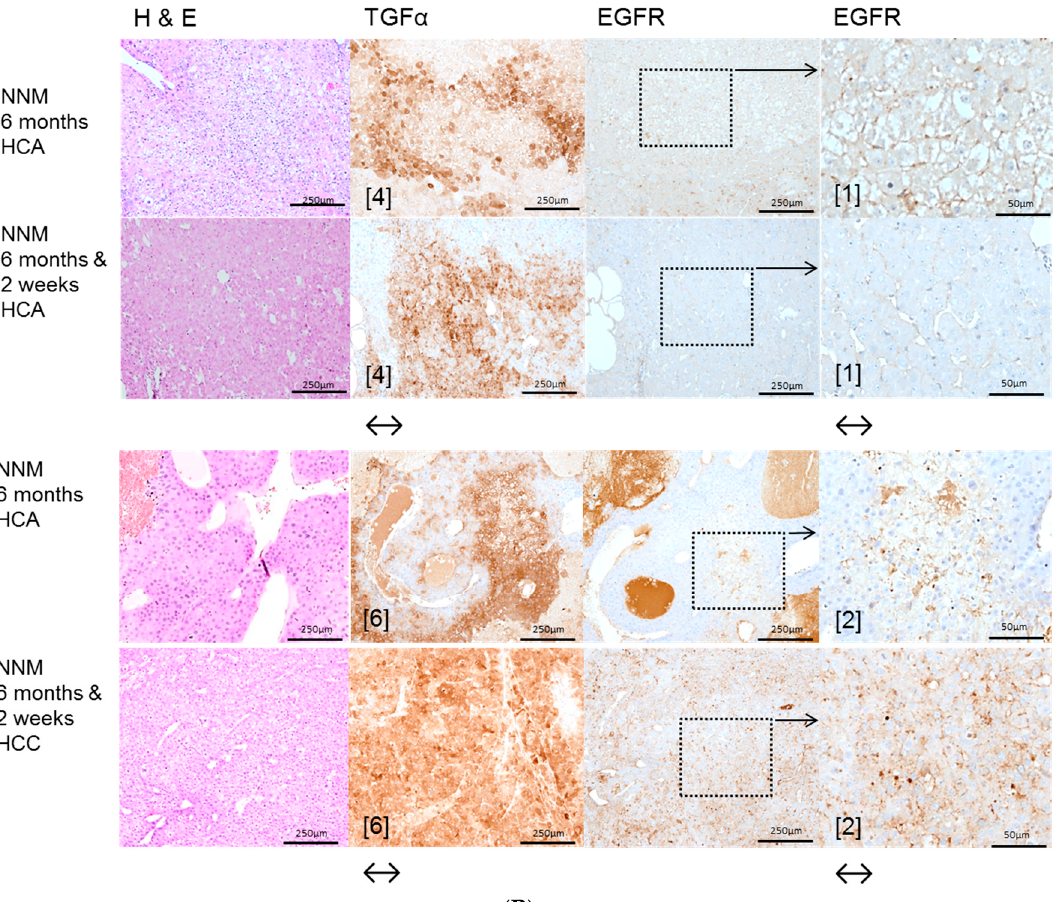
Figure 1. Effects of Gefitinib at six months after administration of N -Nitrosomorpholine (NNM) and expression patterns of epidermal growth factor receptor (EGFR), transforming growth factor α (TGF α ) and downstream signaling in pre-neoplastic foci of altered hepatocytes (FAH) and neoplastic liver lesions. Gefitinib was administered daily for three months (10 mg/kg) ( A ); Glycogen storing foci of altered hepatocytes (FAH) after NNM administration (NNM 6 months) with an overexpression of EGFR and TGF α , which is reduced after Gefitinib treatment for three months (NNM 6 months & 3 months), implying downregulation of proteins of dependent signaling pathways of phosphatidyl-inositide 3 kinase/protein kinase B/mammalian target of rapamycin (PI3K/AKT/mTOR) (p-mTOR and phosphorylated 4E-binding protein 1 (p-4EBP1)) and rat sarcoma/rat sarcoma-activated factor/mitogen activated protein kinase/extracellular regulated kinase kinase (Ras/Raf/MEK/ERK) (Ras and PanERK) pathways, corresponding to less proliferative activity and volume fraction of FAH in Gefitinib treated rats ( B ). After six months of NNM administration (NNM 6 months), hepatocellular adenomas (HCA) and carcinomas (HCC) reveal a strong of TGF α , to a lesser extent of EGFR. Gefitinib treatment for two weeks or three months (NNM (6 months & 2 weeks)/(6 months & 3 months)) does not alter protein expression levels. Immunostaining scores are shown in brackets. Arrows correspond to ↑ upregulation, ↓ downregulation or ↔ unchanged expression level. Expression levels of immunostaining are given in brackets. Magnification: ( A ) overview 40×; marked lesion in dashed lines (PAS and immunostainings) 100×; and ( B ) (H & E and immunostainings) 100×; marked area in dashed lines (EGFR) 400×.